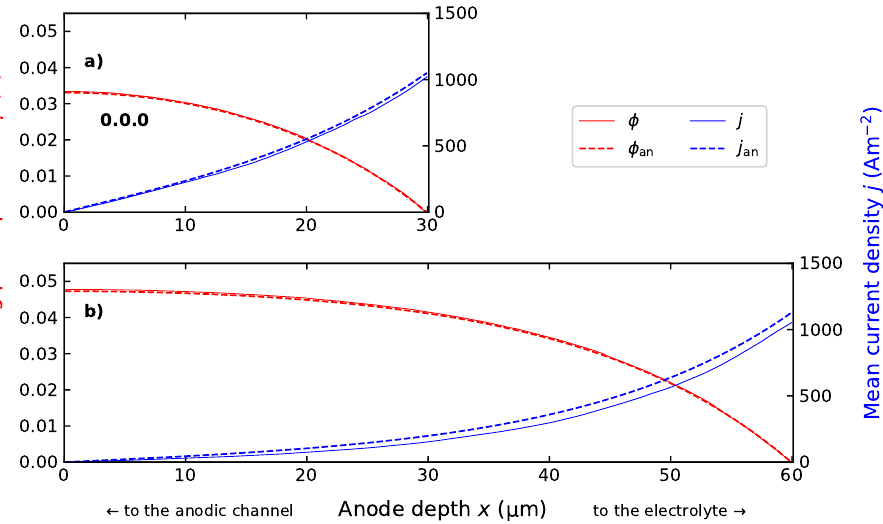
Figure 3. Ionic potential and exchange current density fields in a homogeneous anode. Boundary = 3000 Pa. Thickness: ( a ) 30µm ( b ) 60µm. T = 1073 conditions: φ el,b = 0.05 V, p H = 97,000 Pa, p H 2 2 O